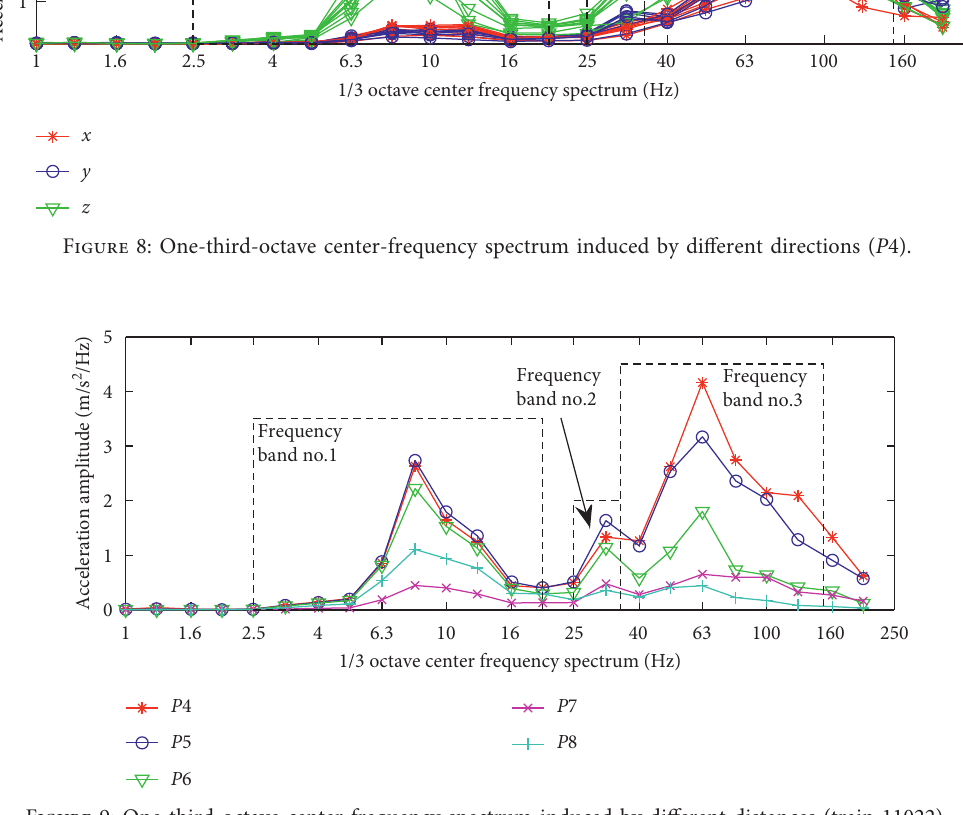
Figure 9: One-third-octave center-frequency spectrum induced by different distances (train